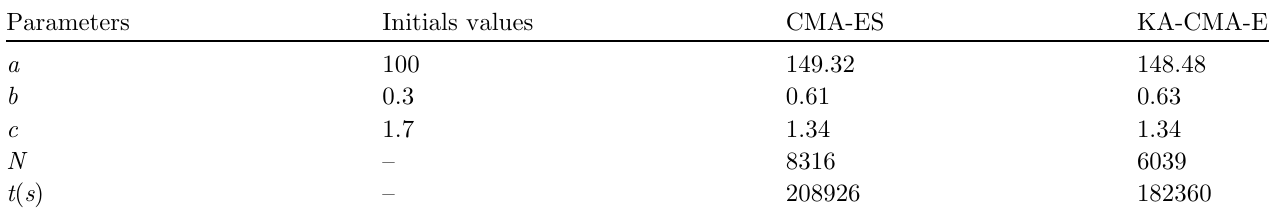
Table 3. Optimization results using CMA-ES and KA-CMA-ES.